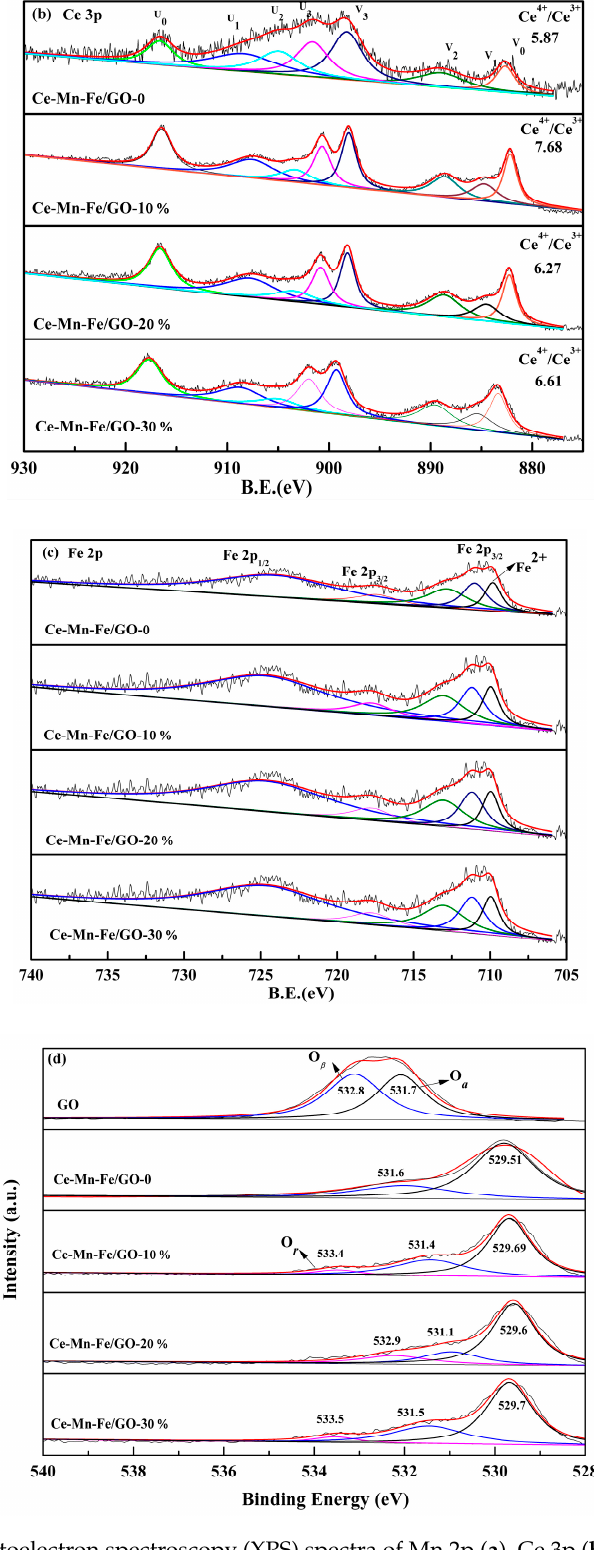
Figure 3. X-ray photoelectron spectroscopy (XPS) spectra of Mn 2p ( a ), Ce 3p ( b ), Fe 2p ( c ) and O 1s ( d ) for Ce-Mn-Fe/GO-x (x = 0, 10%, 20%, 30%).